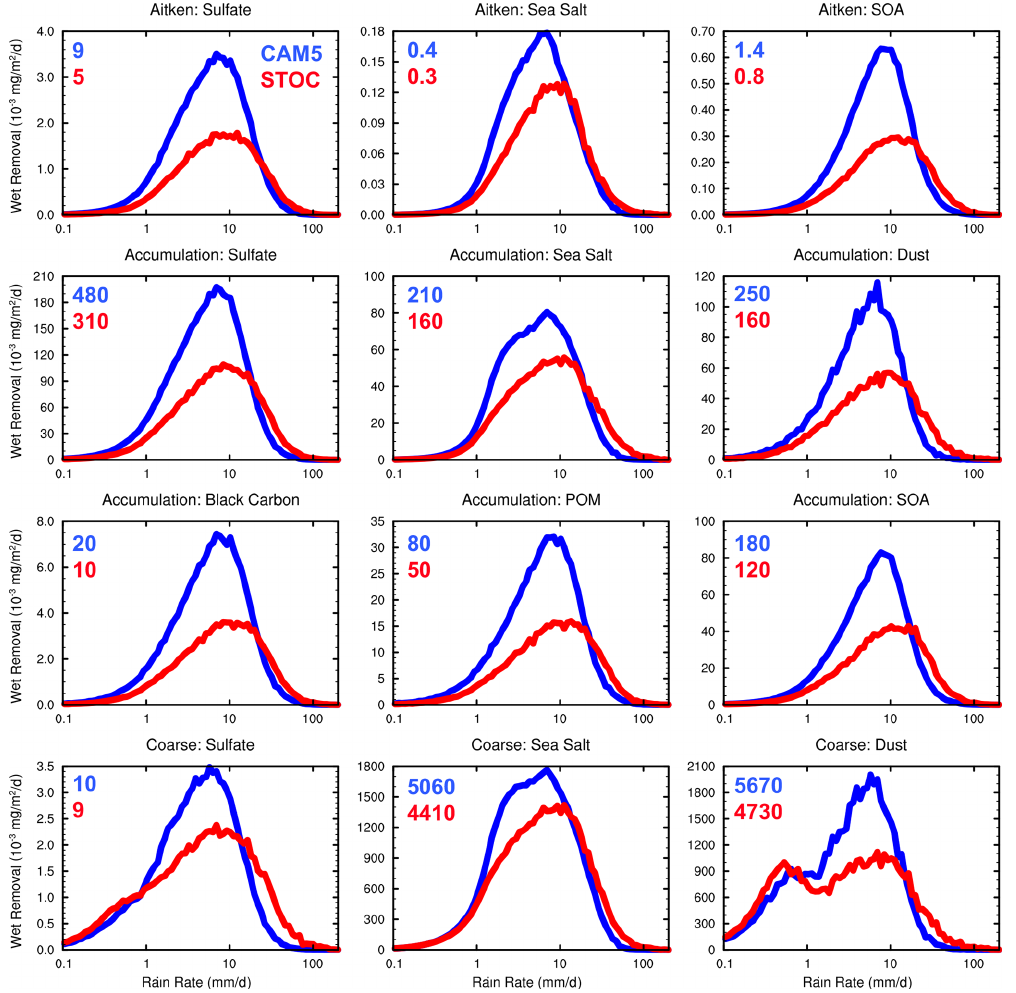
Figure 5. Same as Fig. 4, but over 20, 50 ◦